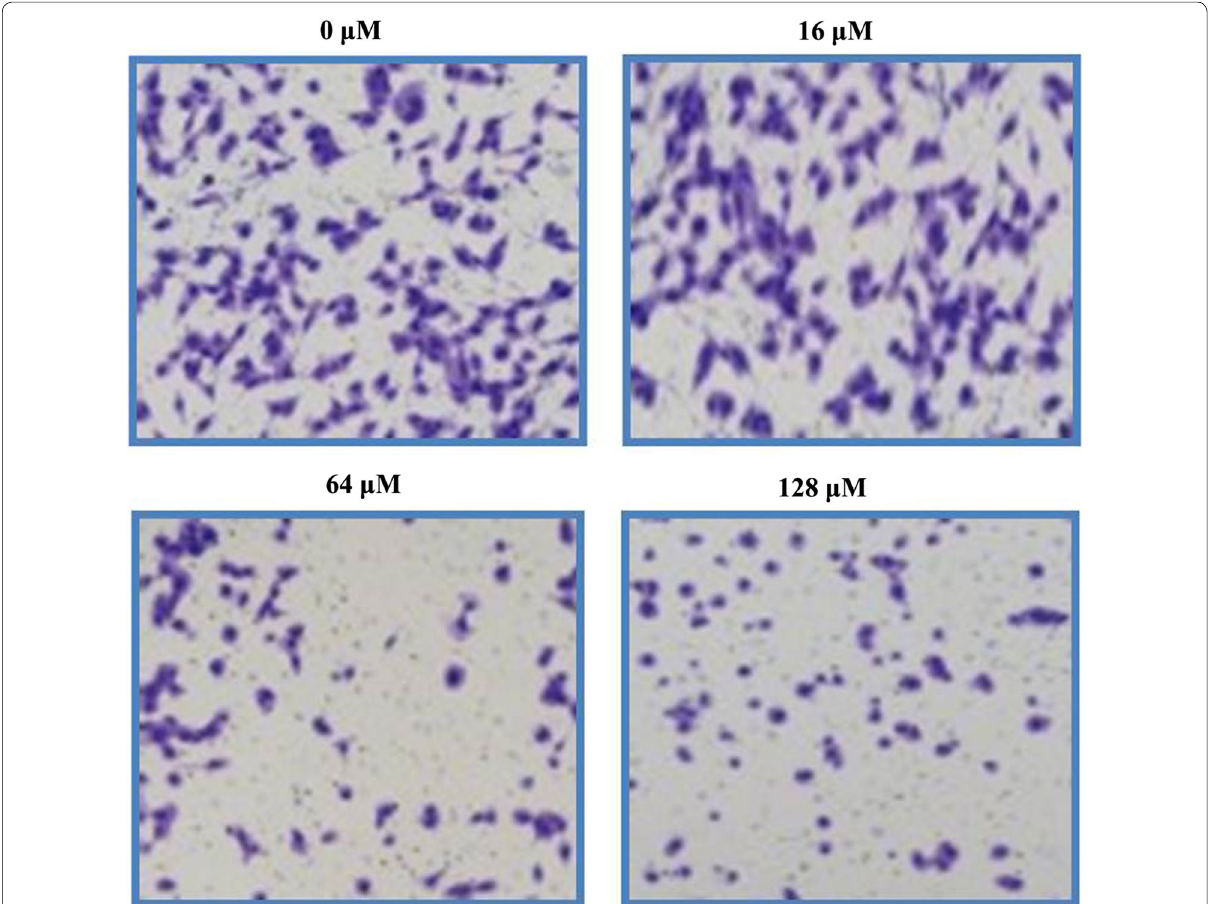
Fig. 9 Transwell chambers assay results revealing the number of invasive HeLa cells after garcinone-E exposure. Individual separate experiments were implemented three